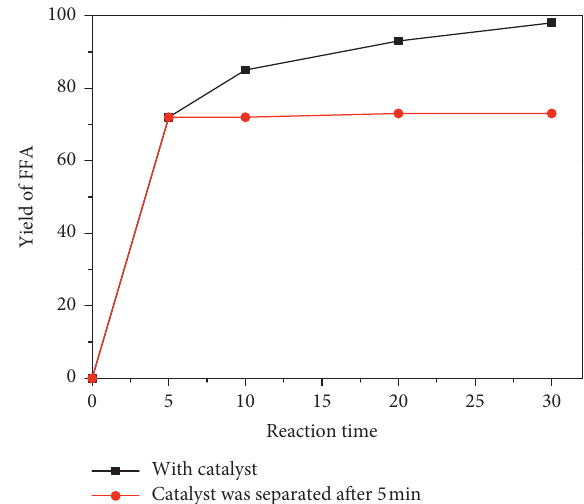
Reaction conditions: 0.5mmol FUR, 25mg 5wt.% KF/ZrO 2 , 2mL DMF, 2.5 equiv. H − of hydrosilane, 25 ° C, and 30min.